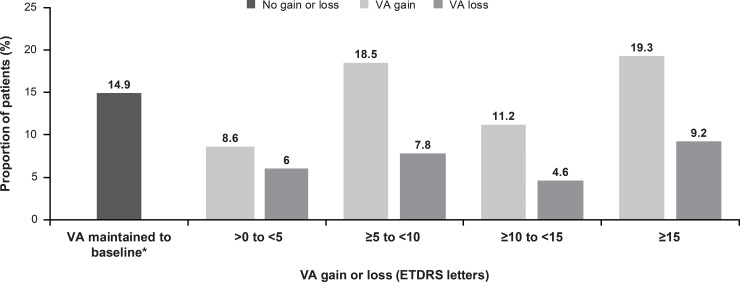
Proportion of patients with a VA gain or loss (primary treated eye set).*Includes patients with 0 letters loss. The primary treated eye set included all primary treated eyes in patients included in the safety set. The safety set consisted of patients in the enrolled set who were treated with at least one dose of ranibizumab during this study or prior to the start of the study and had at least one safety assessment after the first treatment. For treatment-naïve eyes, the date of first on-study injection with ranibizumab was considered the baseline date. For the 1-year time period, all patients with non-missing baseline VA and year 1 VA performed anywhere between Day 319 and Day 409 but who had been in the study for at least 365 days from baseline to last follow-up date were included in the analysis. ETDRS, Early Treatment Diabetic Retinopathy Study; VA, visual acuity.